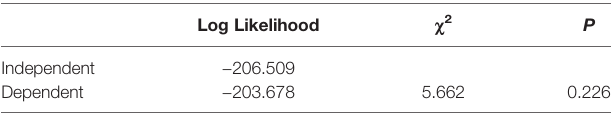
TABLE 2 | Pagel (1994) test of correlated evolution for UV- and human-visible petal patterning in Potentilleae. Log Likelihood